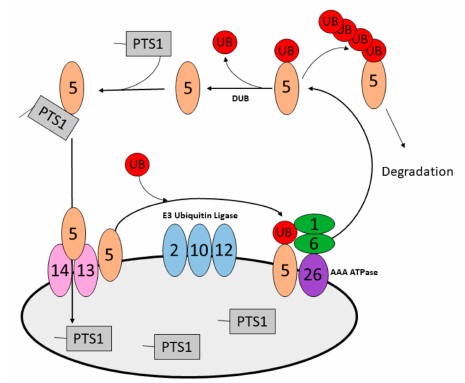
Figure 1. Schematic of the mammalian peroxisome matrix protein import cycle. PEX5 binds PTS1-containing proteins in the cytosol and recruits them to the peroxisome membrane through binding with PEX13-PEX14. Following the deposition of PTS1-containing proteins into the peroxisome lumen, PEX5 is ubiquitinated by the RING-like E3 ubiquitin ligases PEX2, PEX10, PEX12. Ubiquitinated PEX5 is removed from the membrane by the AAA-type ATPase complex, PEX1-PEX6-PEX26. In the cytosol, PEX5 is either deubiquitinated to enable another round of import or polyubiquitinated and proteasomally